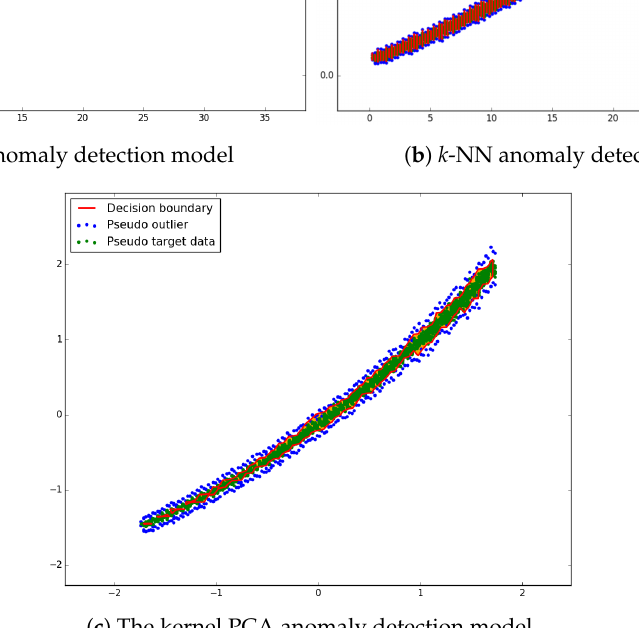
Figure 4. The detection models with final decision